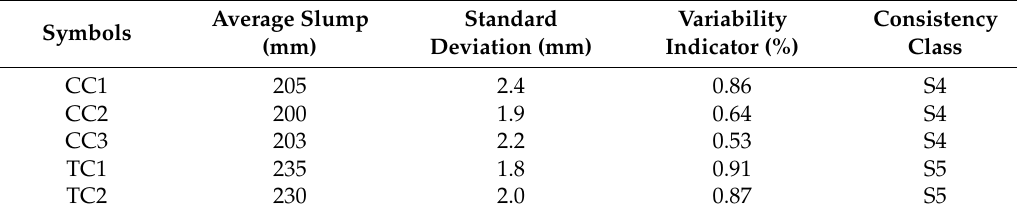
Table 7. The consistency of concrete mixes.